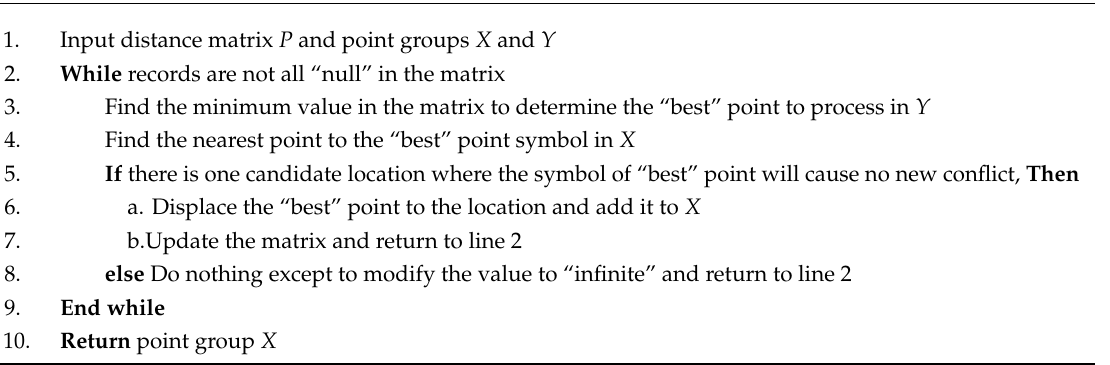
Algorithm 2: Deal with the matrix and displace